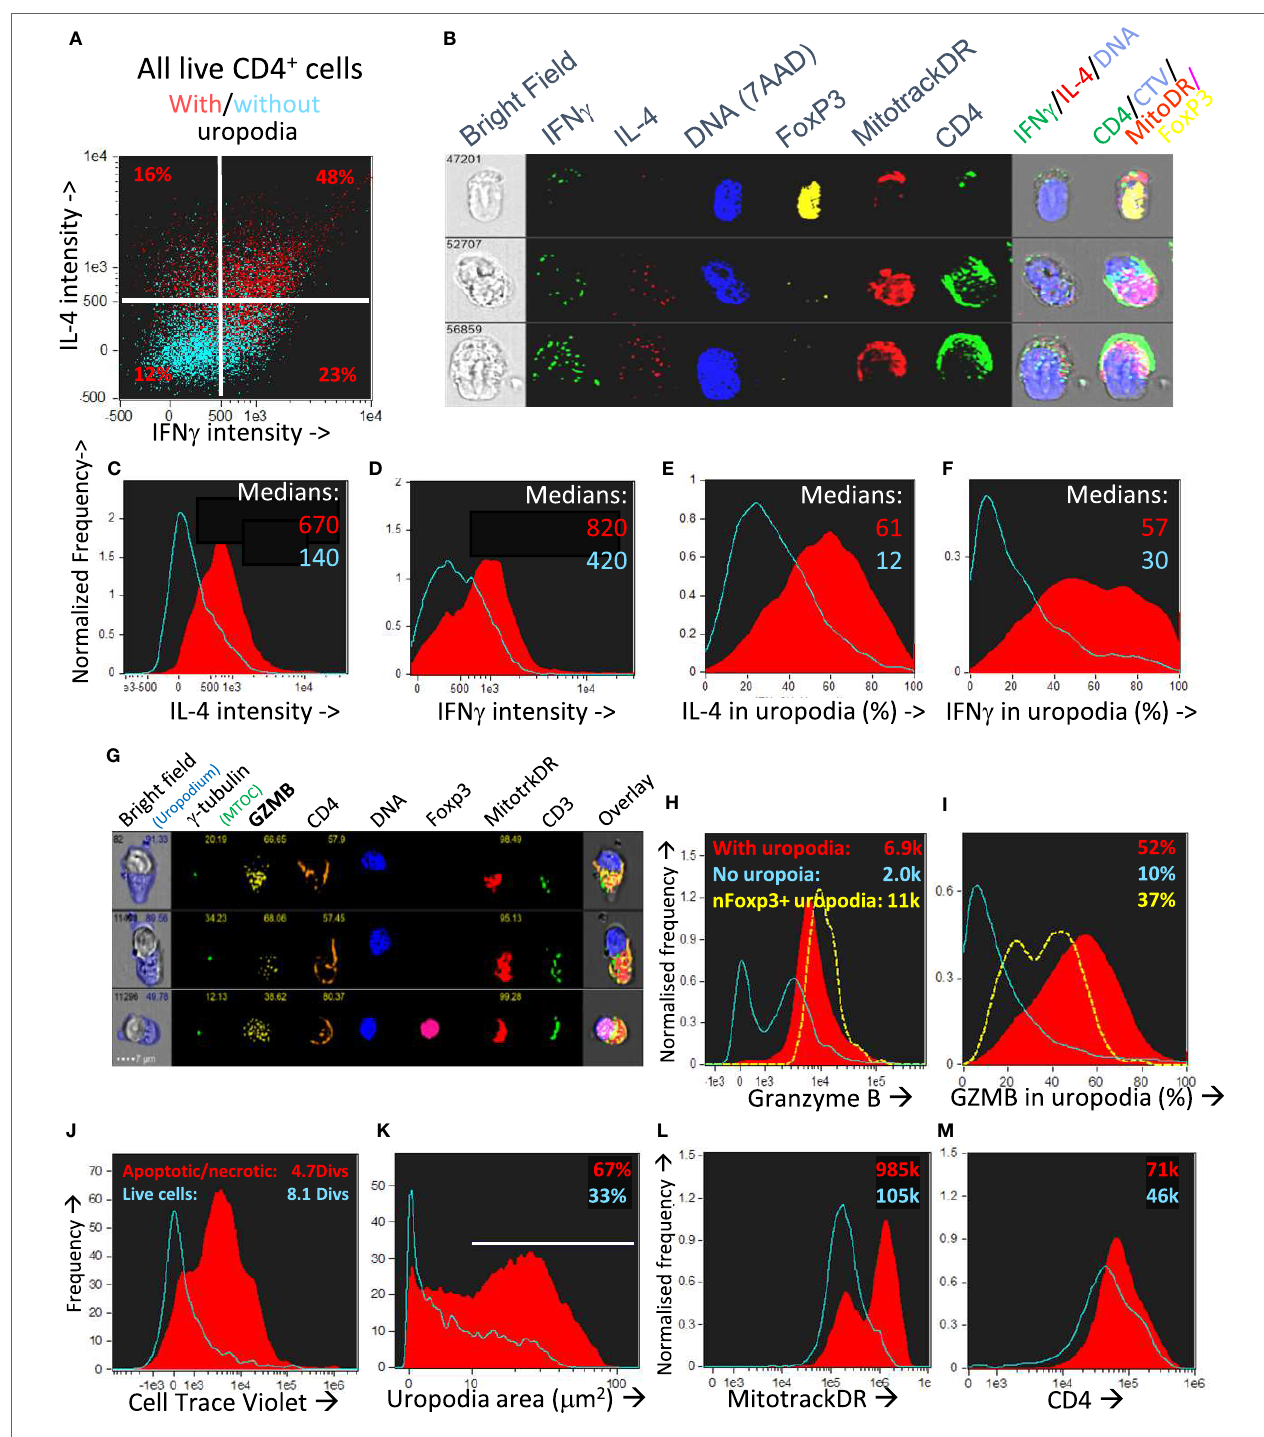
staining and flow cell imaging analysis, we analyzed numer- ous cell surface markers, transcription factors, and signaling molecules across all telophase cells within multiple samples, and never found any evidence of significant